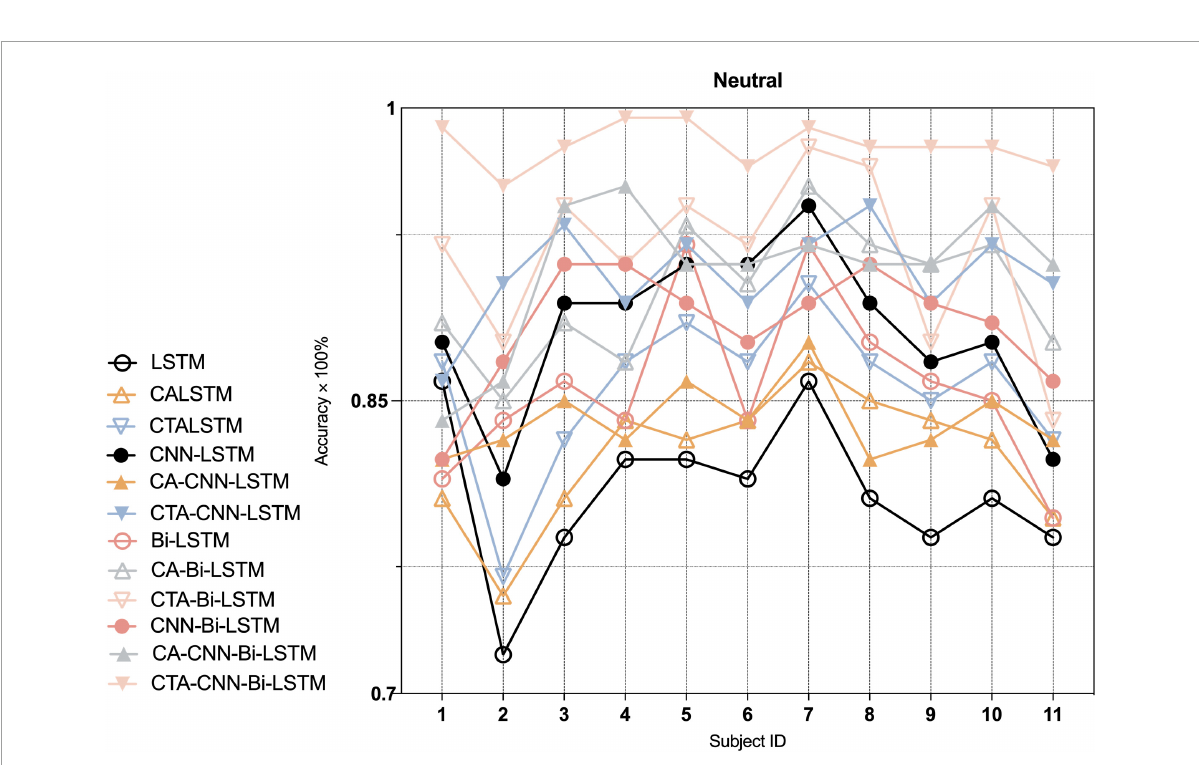
FIGURE8 Average accuracy (%) of baseline and proposed method on the recognition of neutral emotion in each